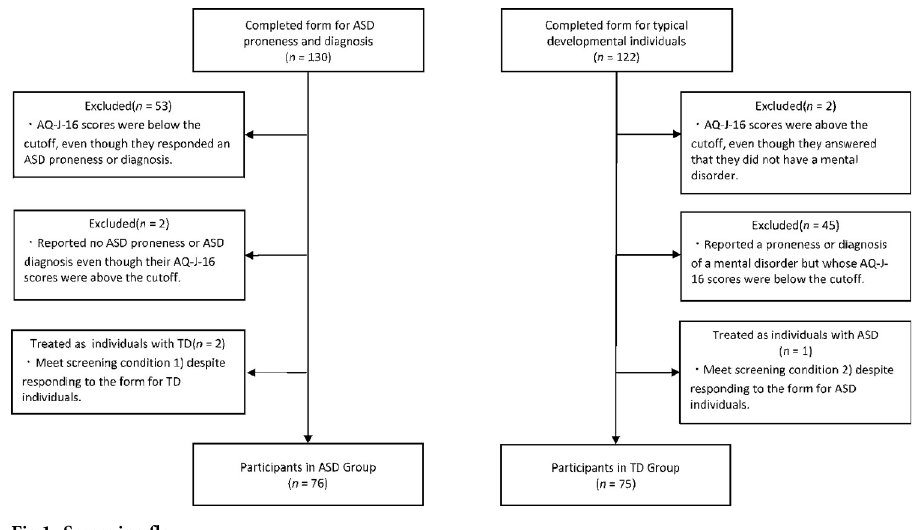
Fig 1. Screening